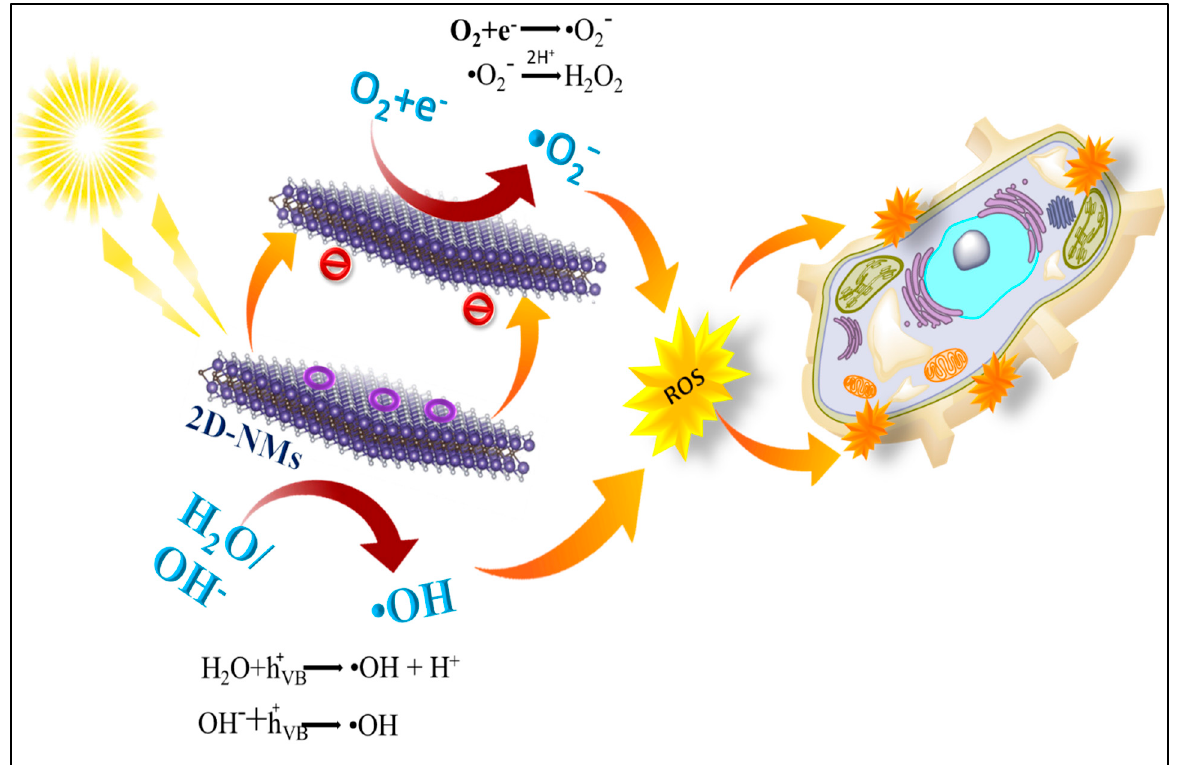
Figure 1. A schematic illustration of 2D-NM-based photo-antibacterial activity.